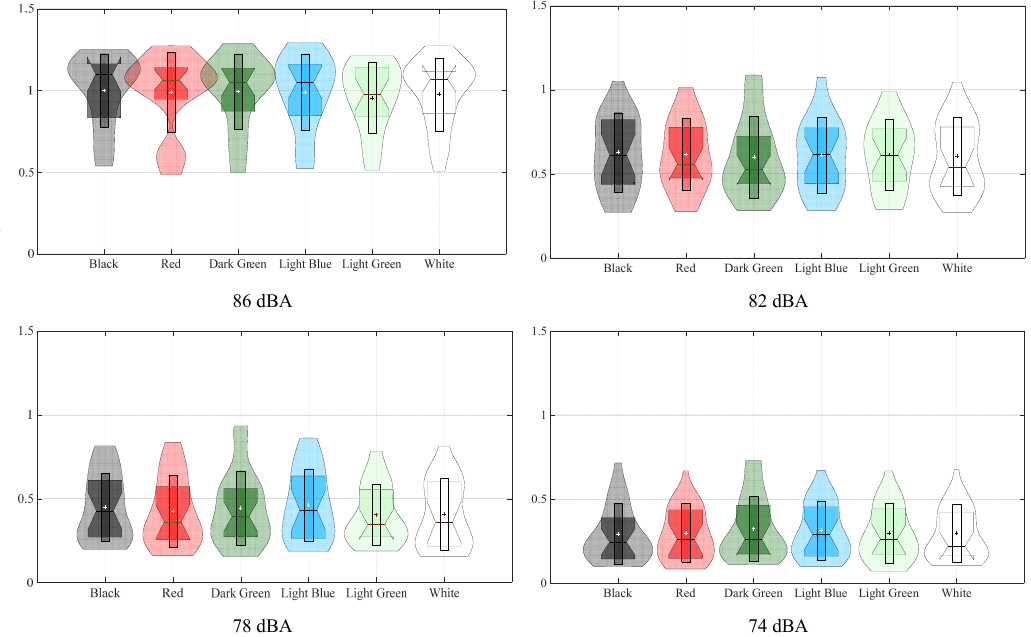
Table 2. ANOVA table (Within Subjects Effects).